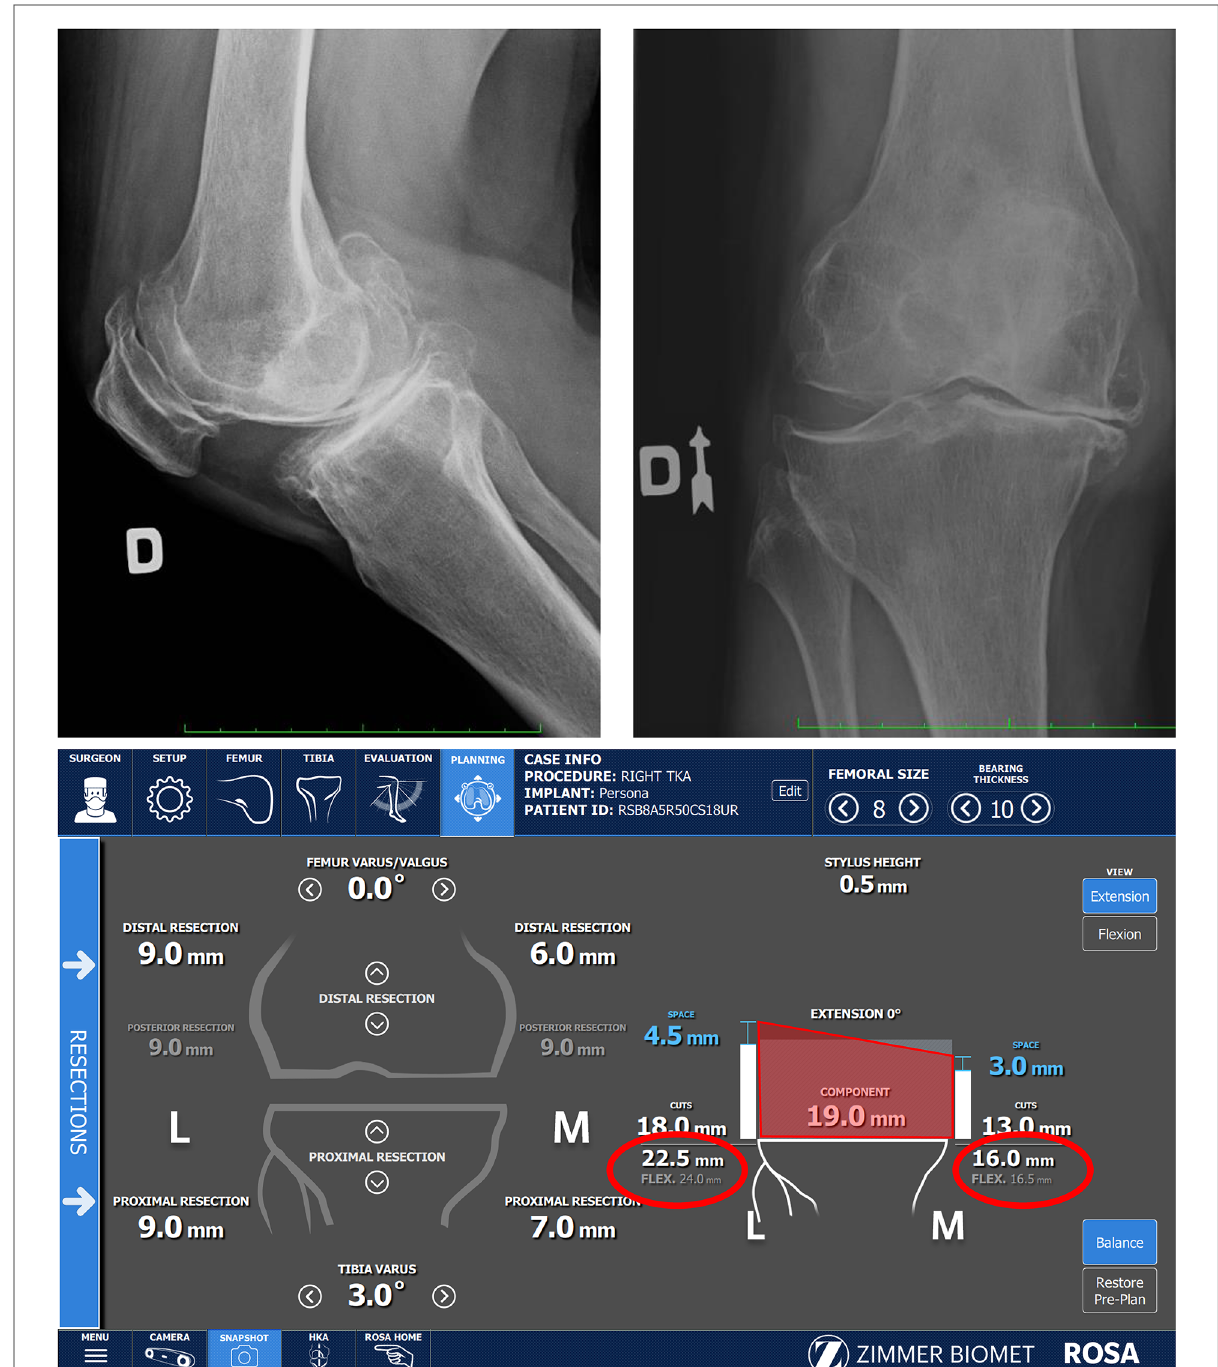
FIGURE 6 Large posterior osteophyte present in x-ray, explaining fl exion deformity. Medial osteophytes still present, as seen in the x-Ray, are re fl ected on the registration screen as inadequate space in the medial compartment (16 mm of space compared to 19 mm component